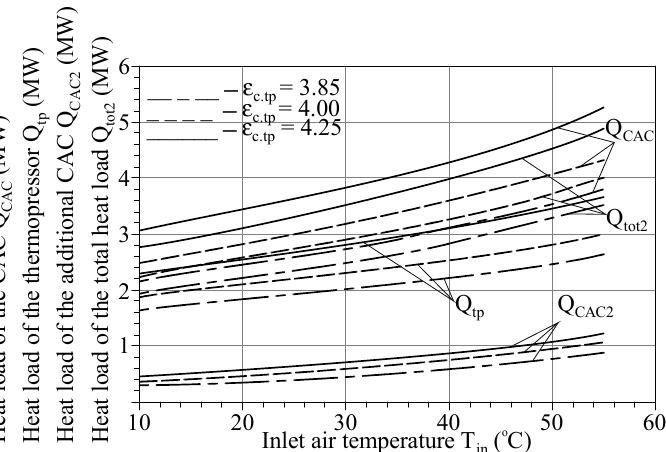
Figure 19. Dependences of the air moisture content at the thermopressor outlet, d tp2 ; air temperature at the thermopressor outlet, T tp2 ; decrease in the additional CAC air temperature, Δ T cac ; degree of pressure increase, ε c ’, at different total pressure increase, ε c . tp , on the inlet air temperature, T in .